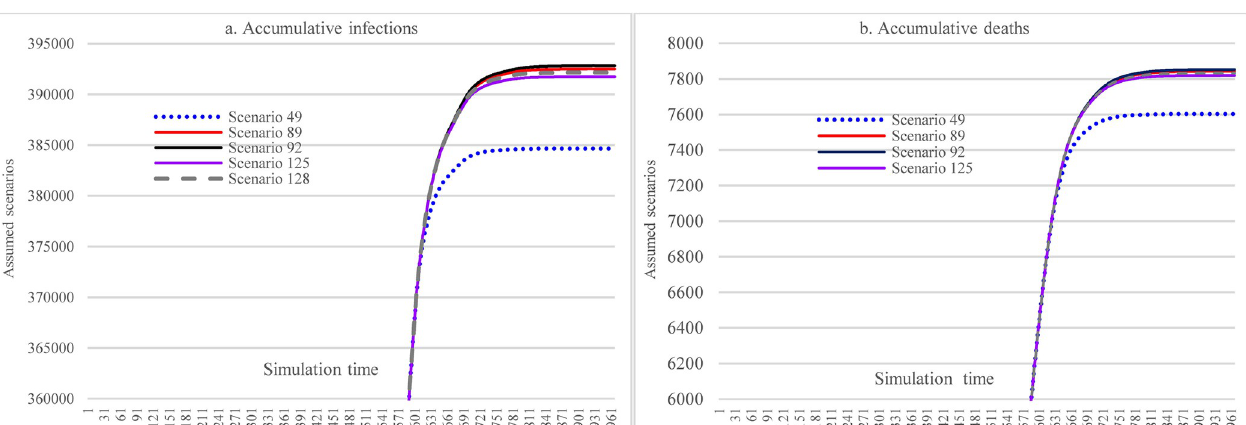
PLOS ONE | https://doi.org/10.1371/journal.pone.0271231 July 26,